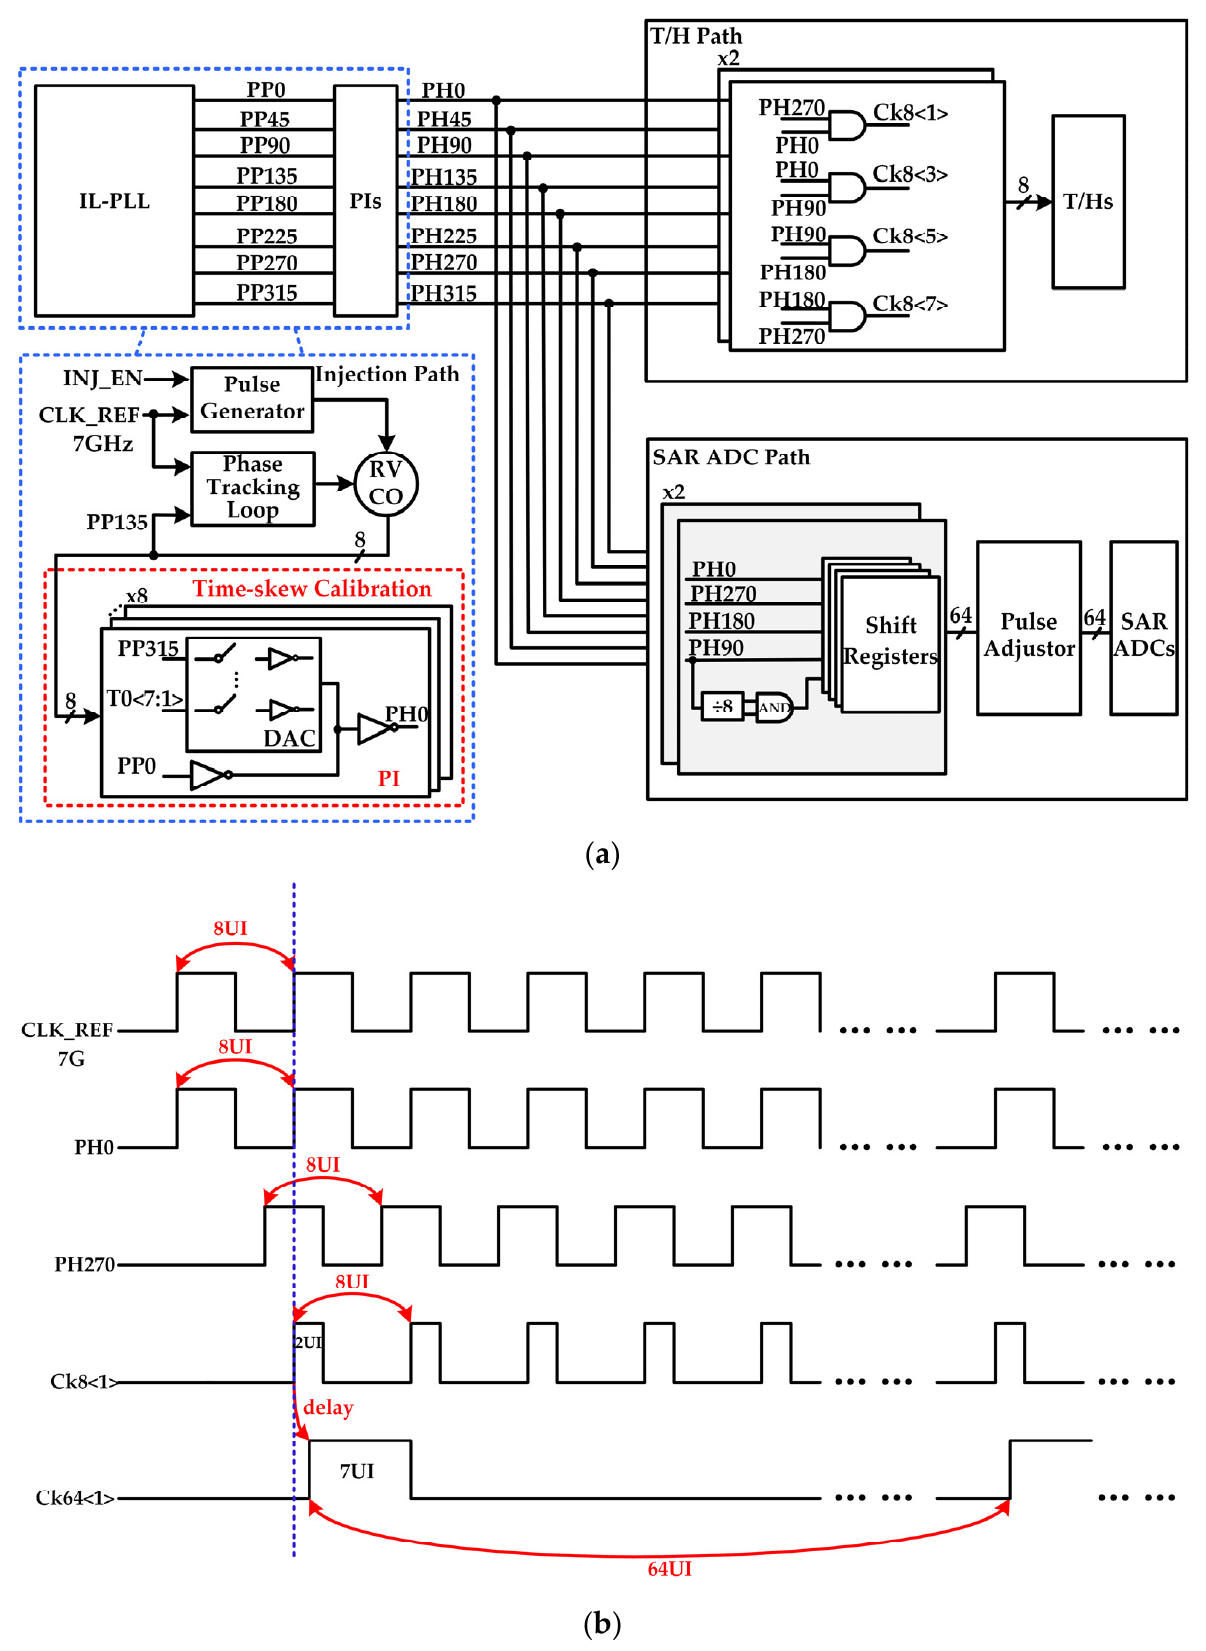
Figure 4. ( a ) Multiple phase clock generator. ( b ) The timing diagram.